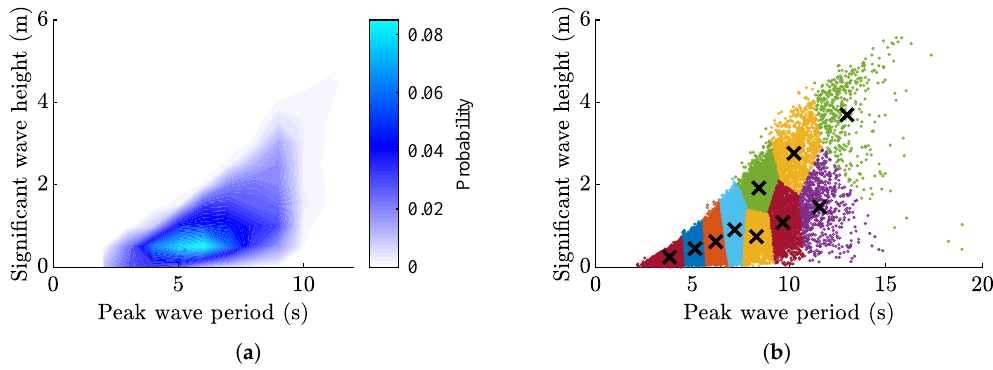
Figure 2. The wave climate at the Marettimo deployment site, Italy (12.04 ◦ E, 37.96 ◦ N, 6.38 kW/m mean annual wave power resource) [37]: ( a ) wave scatter diagram, and ( b ) clustering of the wave data where crosses correspond to ten representative states. Table 1. Ten irregular sea states that represent the Marettimo deployment site. Sea State T p ,